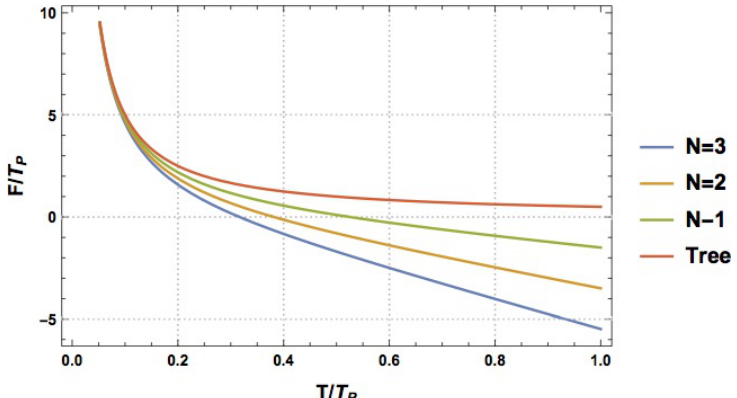
Figure 1 . The free energy as a function of the temperature of Schwarzschild black hole at tree level and including the one-loop contribution. Without loss of generality, we exclude the graviton and set N s = N f = 0.